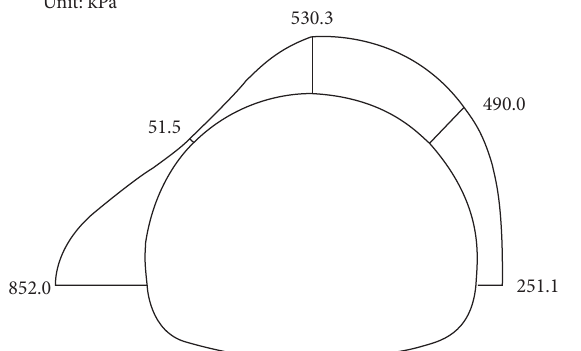
Figure 13: Cross-sectional diagram of the spatial distribution of pressure of the surrounding rock in a typical cross-section tunnel. Table 2: Results of test on pressure of the surrounding rock in similar projects.